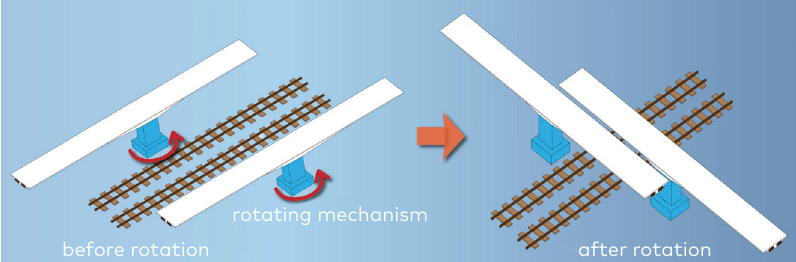
rotating mechanism before rotation after Figure 1. Illustration of the rotation superstructure construction method